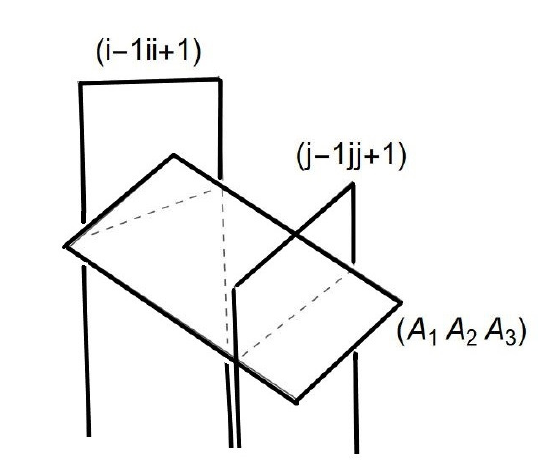
Figure 5 . The dotted lines are common plane ( A 1 A 2 A 3 ) intersecting ( i (cid:0) 1 ii +1) and ( j (cid:0) 1 jj +1). ‘ total # of topologies possible contributions % 4 8 4